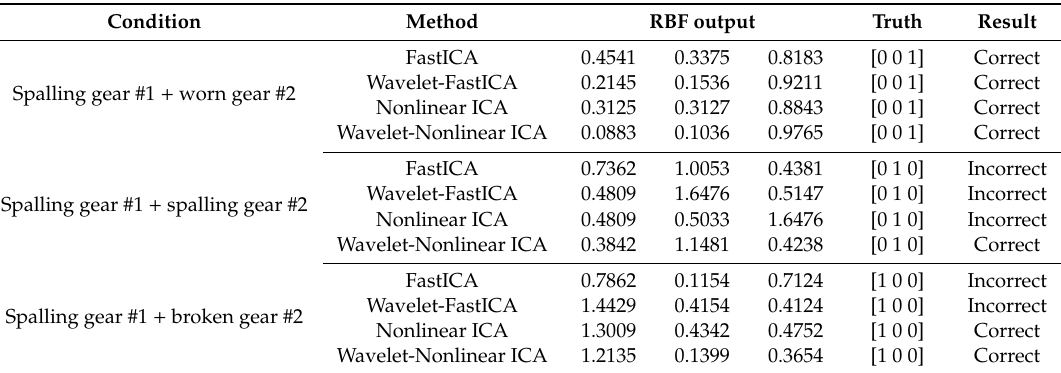
Table 2. Diagnostic